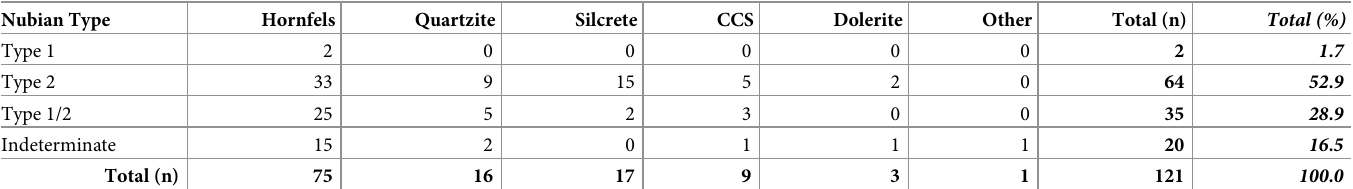
Table 5. Frequencies of Nubian core types at Tweefontein by raw material.